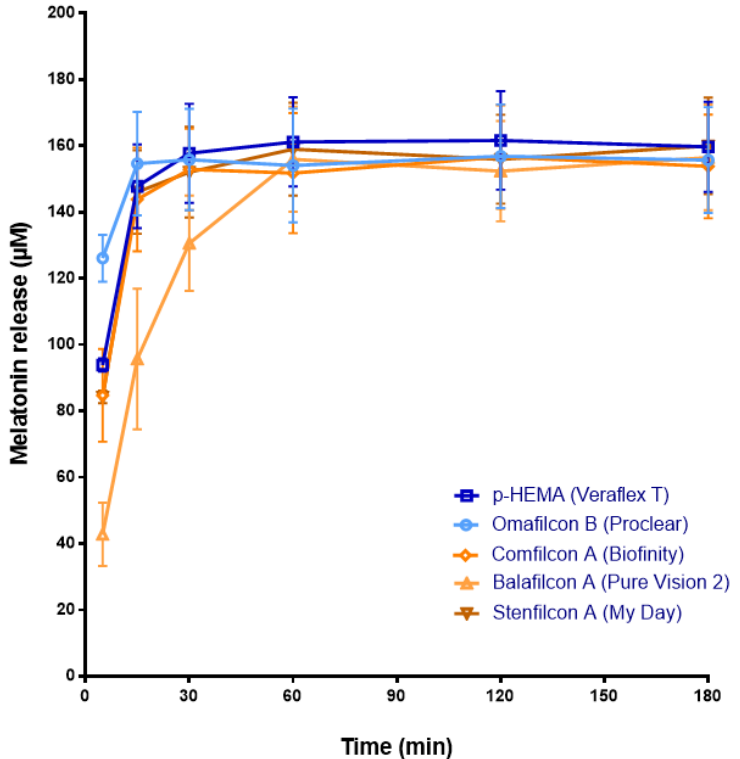
Figure 2. The melatonin release from CLs previously soaked with melatonin solution (1 mL, 1 mM) for 12 h to a saline solution (1 mL) over 180 min. Concentration ( µ M) values are presented as the mean ± S.D of n = 9 lenses per material. The blue color shows the release from CH CLs. The ochre color shows the release from SH CLs.